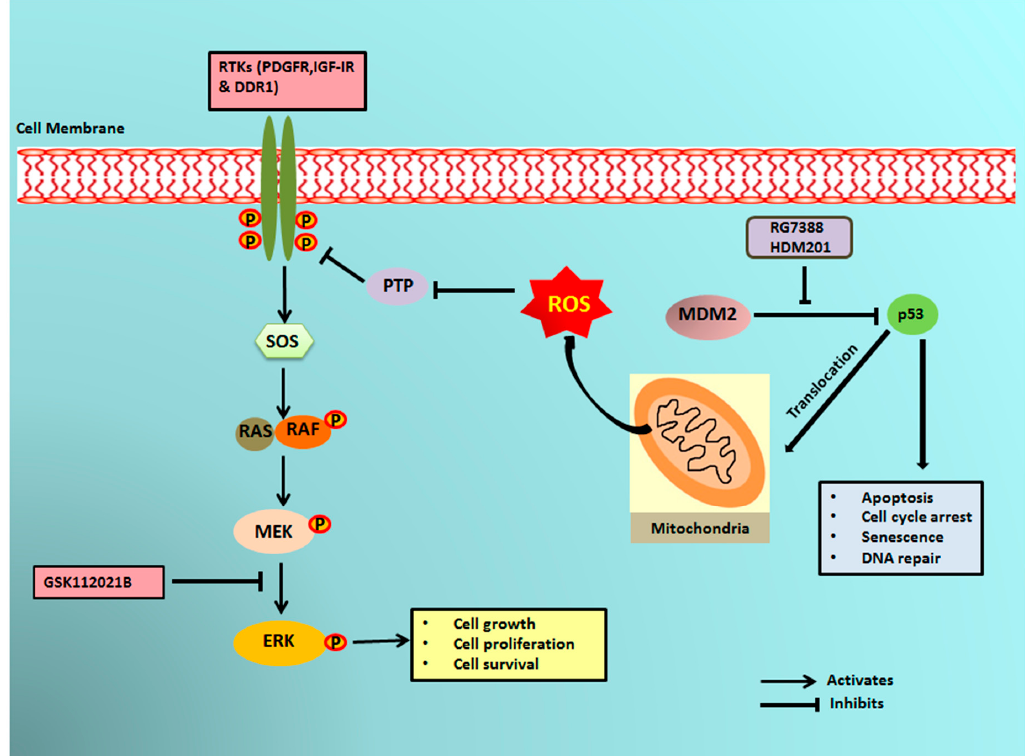
Figure 6. Schematic representation of MDM2 antagonist-induced phosphorylation of ERK1/2 through mitochondrial p53. MDM2 antagonists activate p53, which translocates into the mitochondria and causes elevated production of reactive oxygen species (ROS). The ROS produced inhibits the protein tyrosine phosphatases (PTPs), resulting in phosphorylation of receptor tyrosine kinases (RTKs) like PDGFR, IGF-1R, and DDR1. The activated RTKs then activate the ERK pathway.